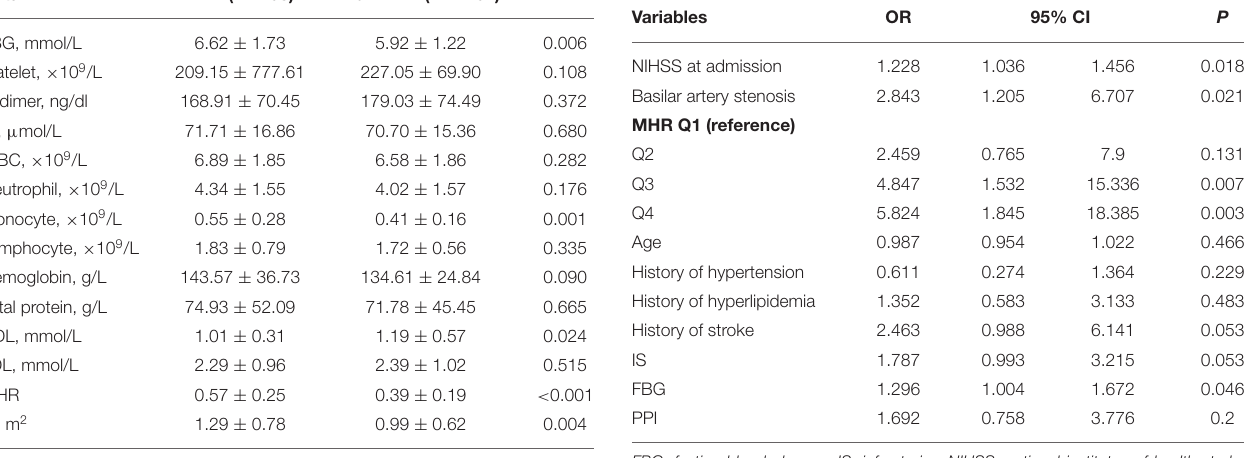
using multivariate logistic regression models. Variables